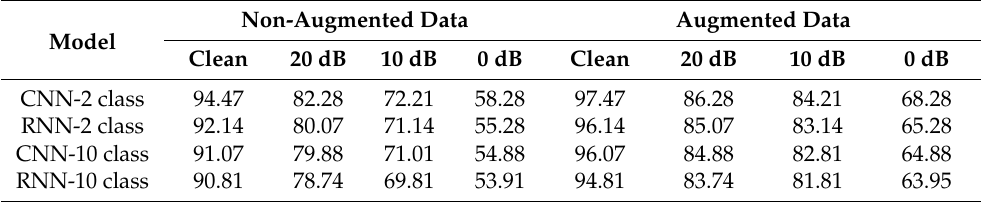
Figure 4. Impact of noisy data with augmented dataset. Table 10. Model Performance based on accuracy (with and without data augmentation).